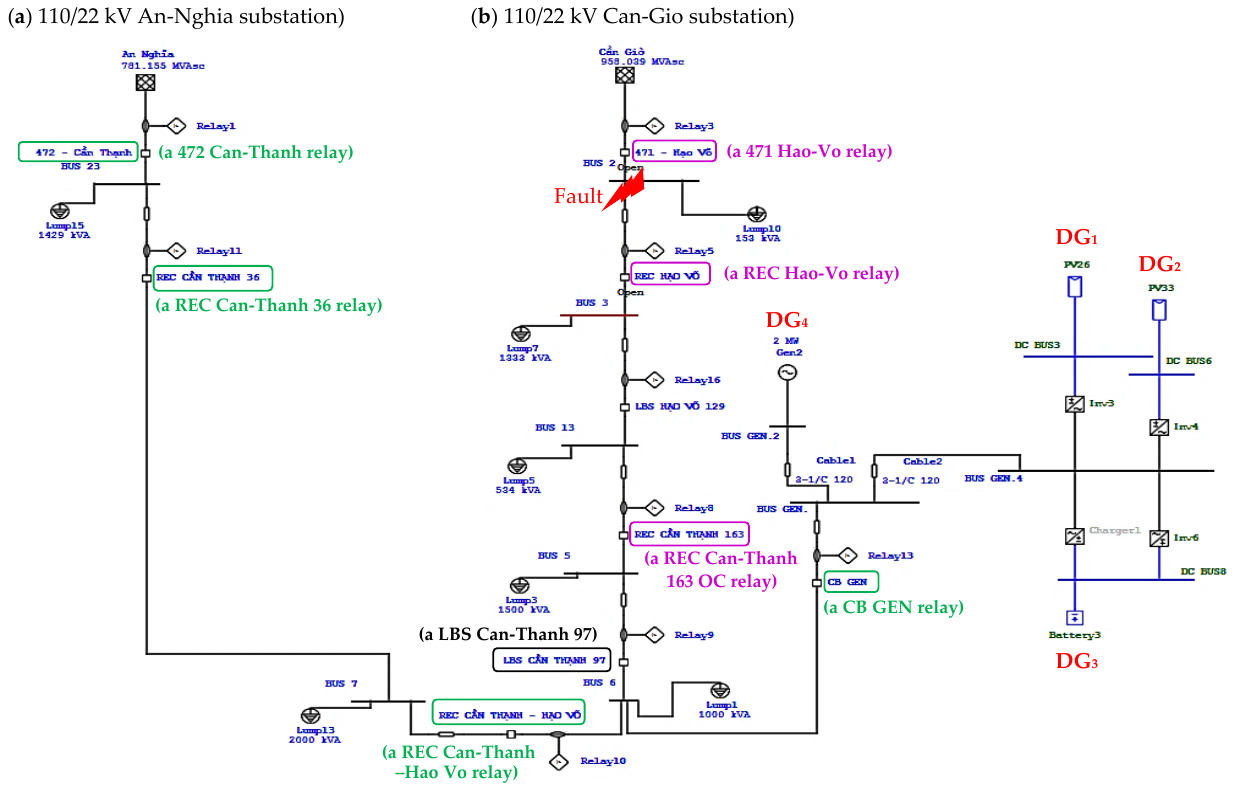
Figure 9. A real 22 kV DG-based distribution network is supplied by two power substations, namely, the 110/22 kV Can-Gio substation and the 110/22 kV An-Nghia substation, three IBDGs (DG 1 , DG 2 , and DG 3 ), and one RBDG (DG 4 ).